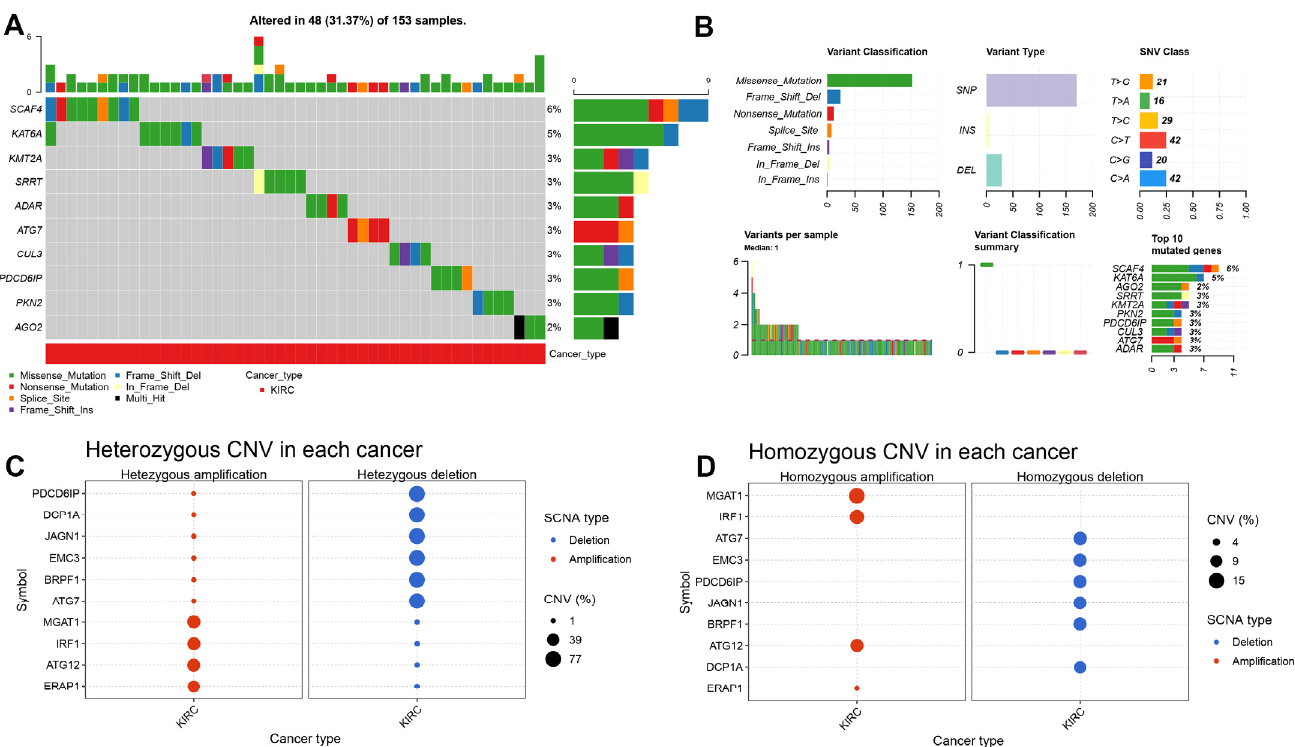
Figure 1. Copy number variation of core cancer innate immune escape genes in ccRCC. ( A ) The top 10 genes with the highest mutation rate in ccRCC. ( B ) Genomic alteration of immune escape genes in ccRCC. ( C ) The top 10 genes with the most significant heterozygous CNVs in ccRCC. ( D ) The top 10 genes with the most significant homozygous CNVs in ccRCC.